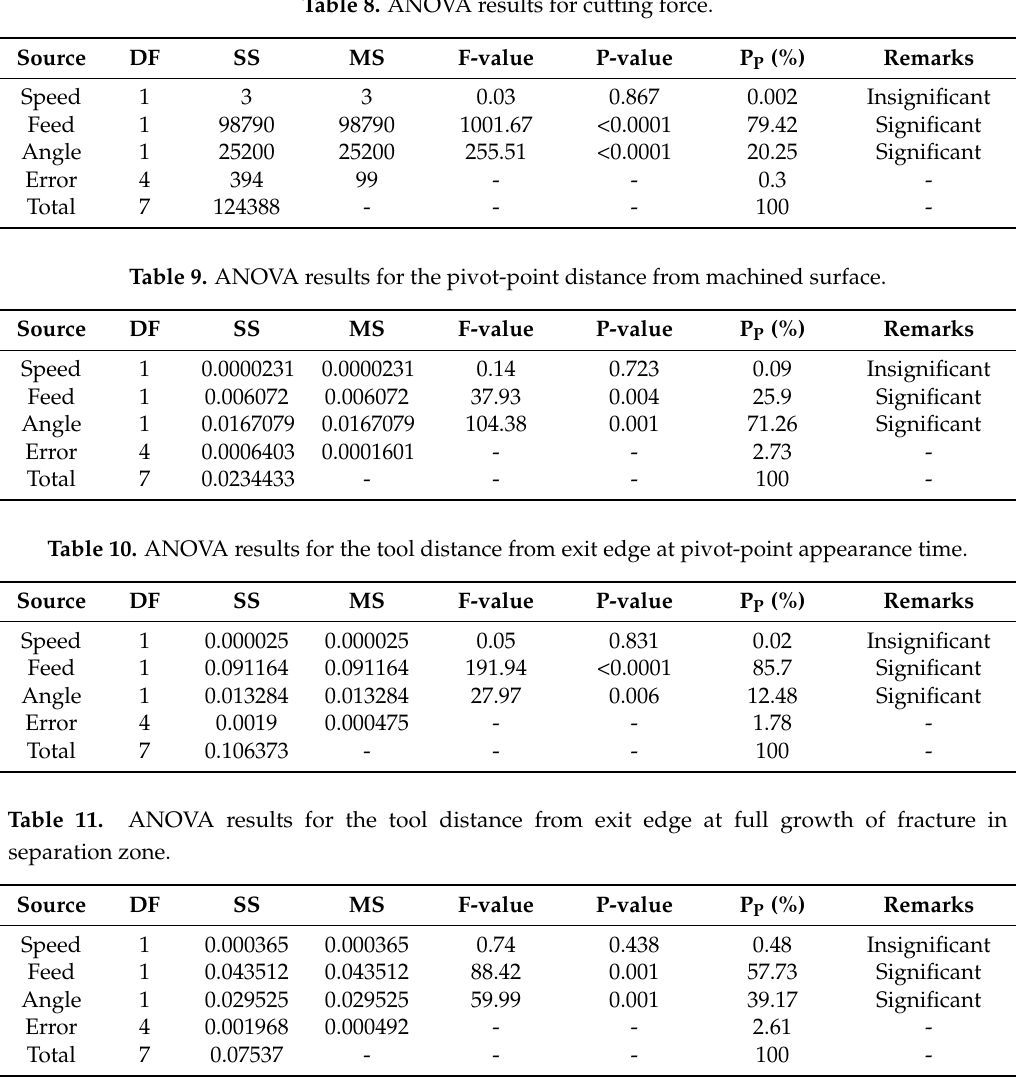
Table 8. ANOVA results for cutting force.